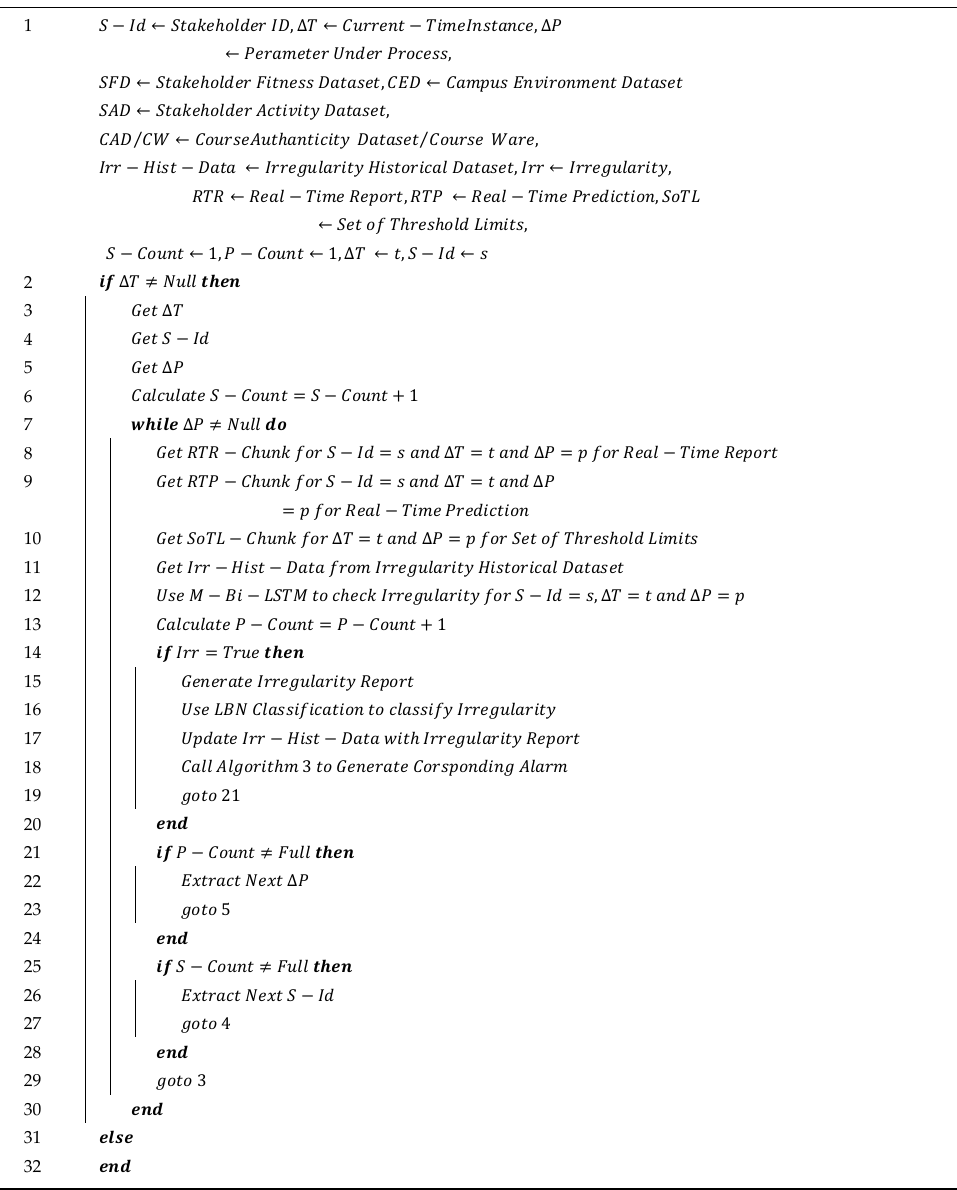
Algorithm 2: Irregularity Detection Algorithm